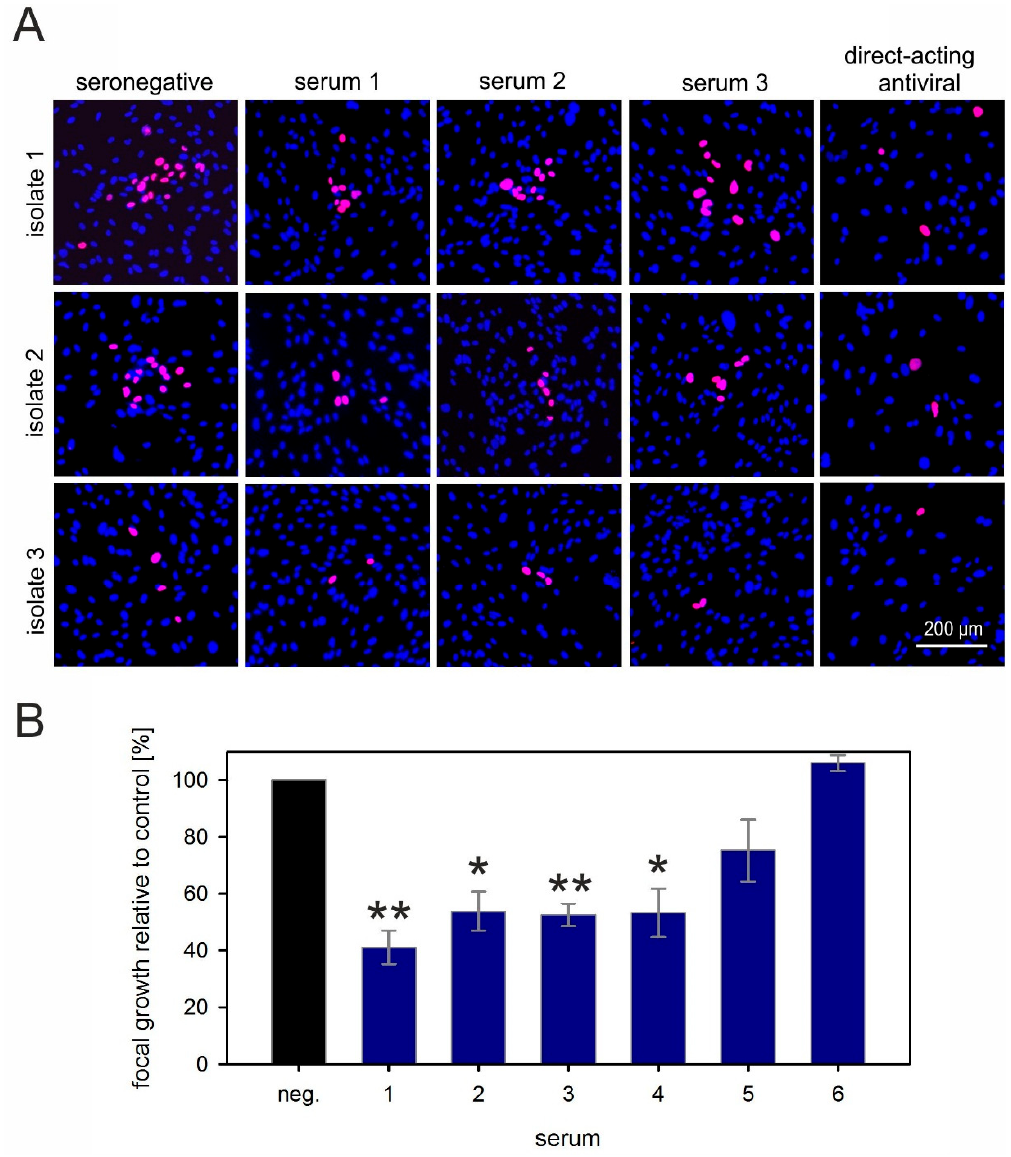
Figure 4. Highly neutralizing sera can partially reduce cell-associated spread of HCMV in endothelial cells. ( A ) Fibroblasts infected with cell-associated clinical HCMV isolates were cocultured with an excess of endothelial cells (HEC-LTTs) and, the following day, sera from highly neutralizing blood donors were added to the coculture. Addition of seronegative human serum and a direct-acting antiviral served as a negative and positive control, respectively. The cocultures were then incubated for six days more to allow for cell-associated viral spread, followed by fluorescence staining for viral IE antigens (red signal). Nuclei of cells were stained with DAPI (blue signals). Three representatives out of six tested sera are shown. ( B ) To quantify the effect of sera on focal growth, the overall numbers of infected cells per well were counted and divided by the number of infected cells cultured in HCMV-seronegative serum (neg). Each bar represents the mean value obtained with three different clinical isolates. Error bars reflect the SEM. Asterisks indicate significant (*) or highly significant (**) differences as compared with the control (neg).